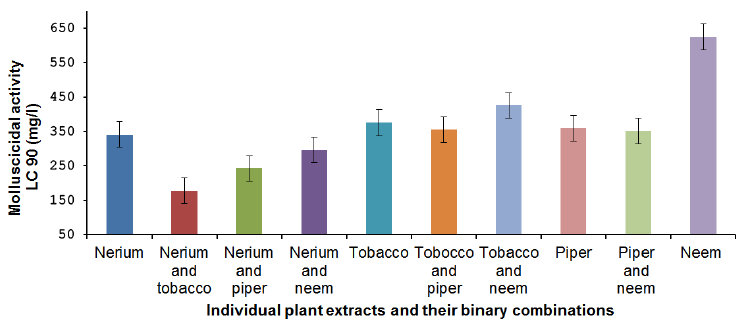
Figure 2. Comparison of molluscicidal activity (LC 90 ) of individual and binary combinations of plant extracts against P. maculata .